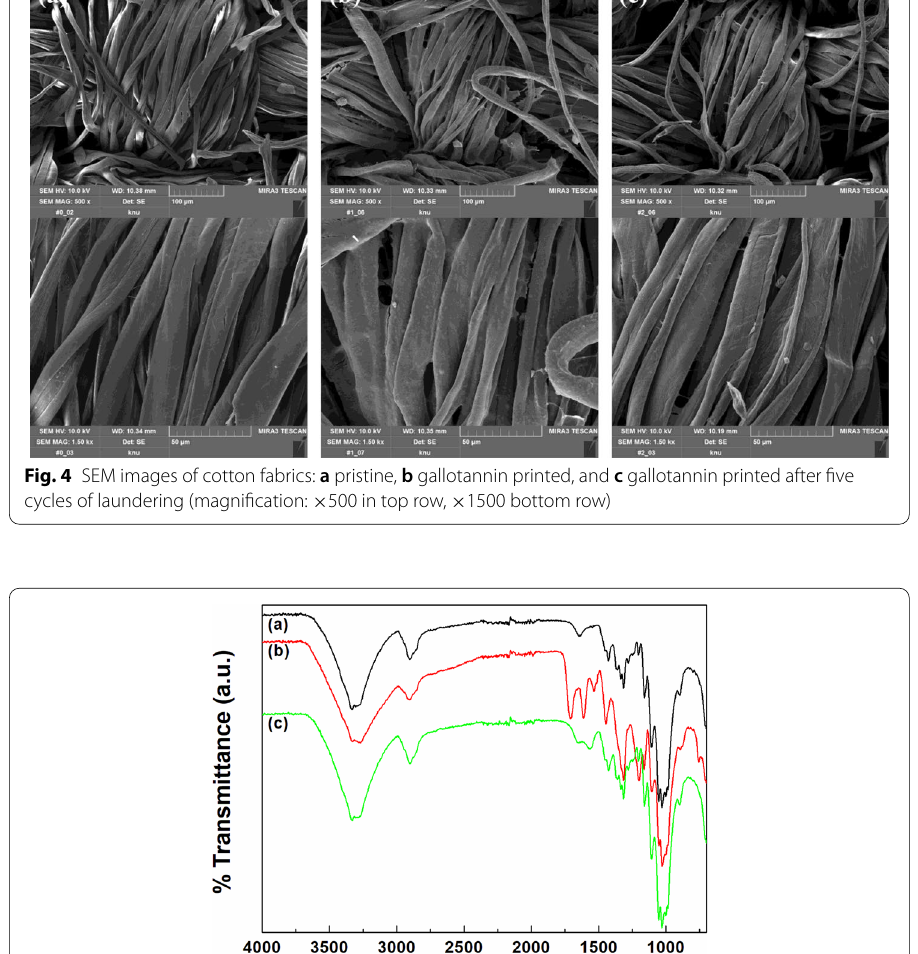
Fig. 5 FTIR-ATR spectra of gallotannin-printed cotton fabrics: a pristine, b gallotannin printed, c gallotannin printed after five cycles of